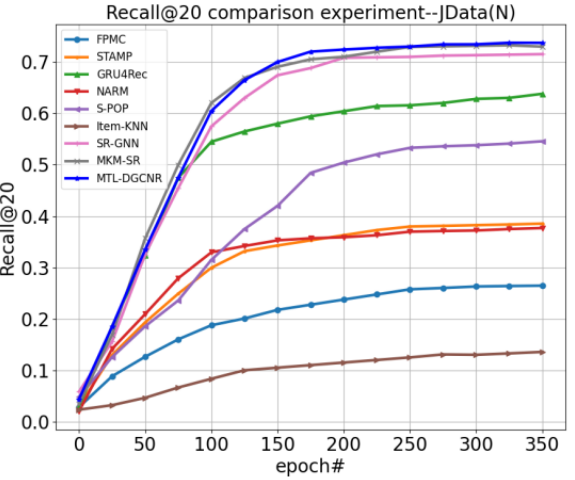
Figure 7. Recall@ 20 change graph on Retailrocket.